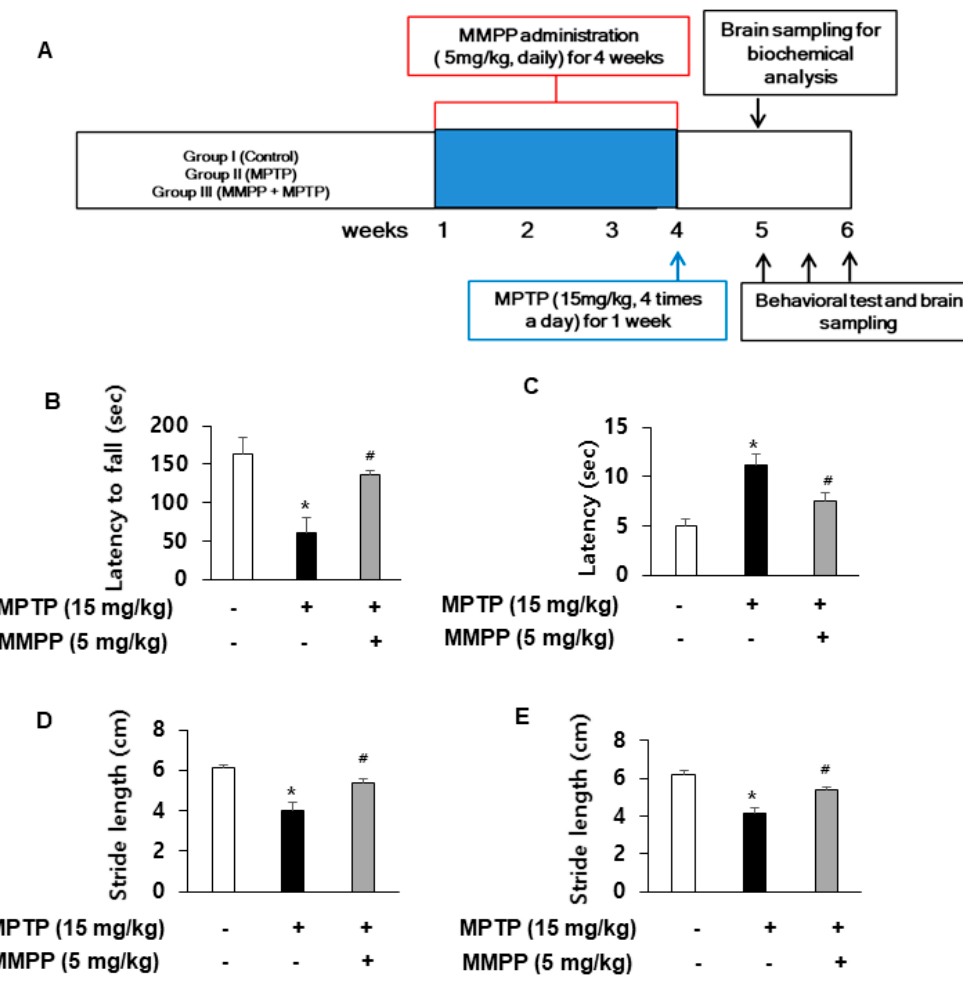
Figure 1. (E)-2-methoxy-4-(3-(4-methoxyphenyl) prop-1-en-1-yl) phenol (MMPP) ameliorates 1-methyl-4-phenyl-1,2,3,6-tetrahydropyridine (MPTP)-induced behavior disorder: Performance on the rotarod is impaired in MPTP-injected groups. The drug administration and experimental schedule is shown ( A ). The impairment is ameliorated in MPTP-injected MMPP-treated groups ( B ). MPTP-induced bradykinesia is ameliorated in MPTP-injected MMPP treated groups ( C ). Stride lengths of forelimbs ( D ) and hindlimbs ( E ) are increased by MMPP treatment in MPTP-injected groups. Values are presented as mean ± SD from 10 mice. * p < 0.05, significant di ff erence from saline-injected mice; # p < 0.05, significant di ff erence between MPTP-injected groups.